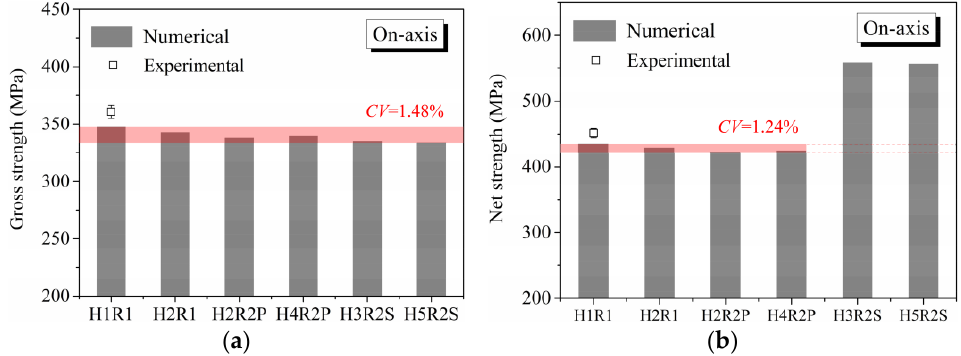
Figure 9. Effect of hole arrangement on notched strength of on-axis Glare: ( a ) Gross notched strength; ( b ) Net notched strength.